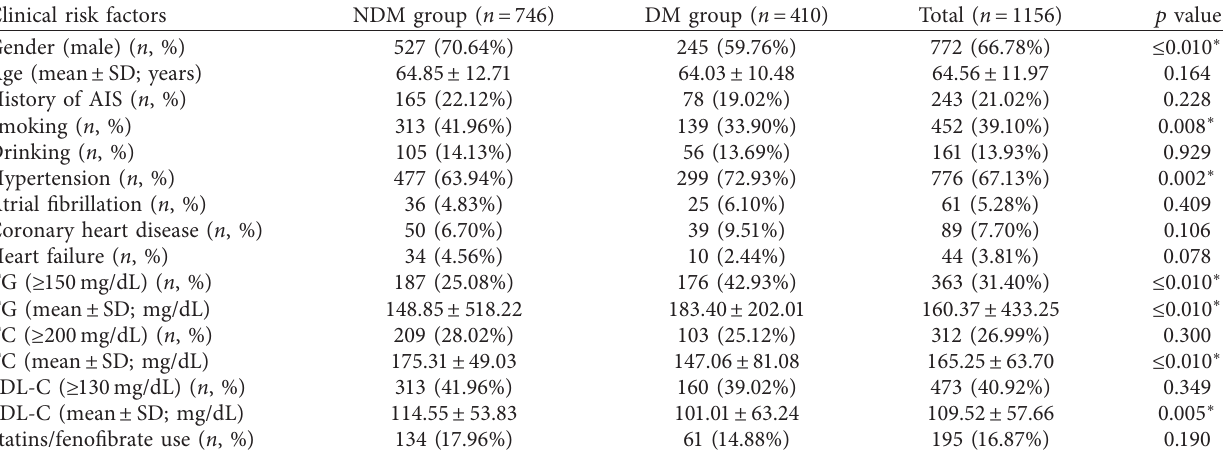
Table 1: Clinical risk factors of study